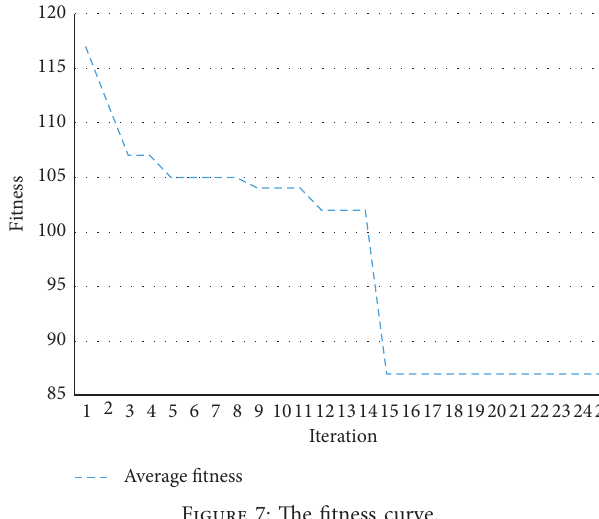
Figure 7: The fitness